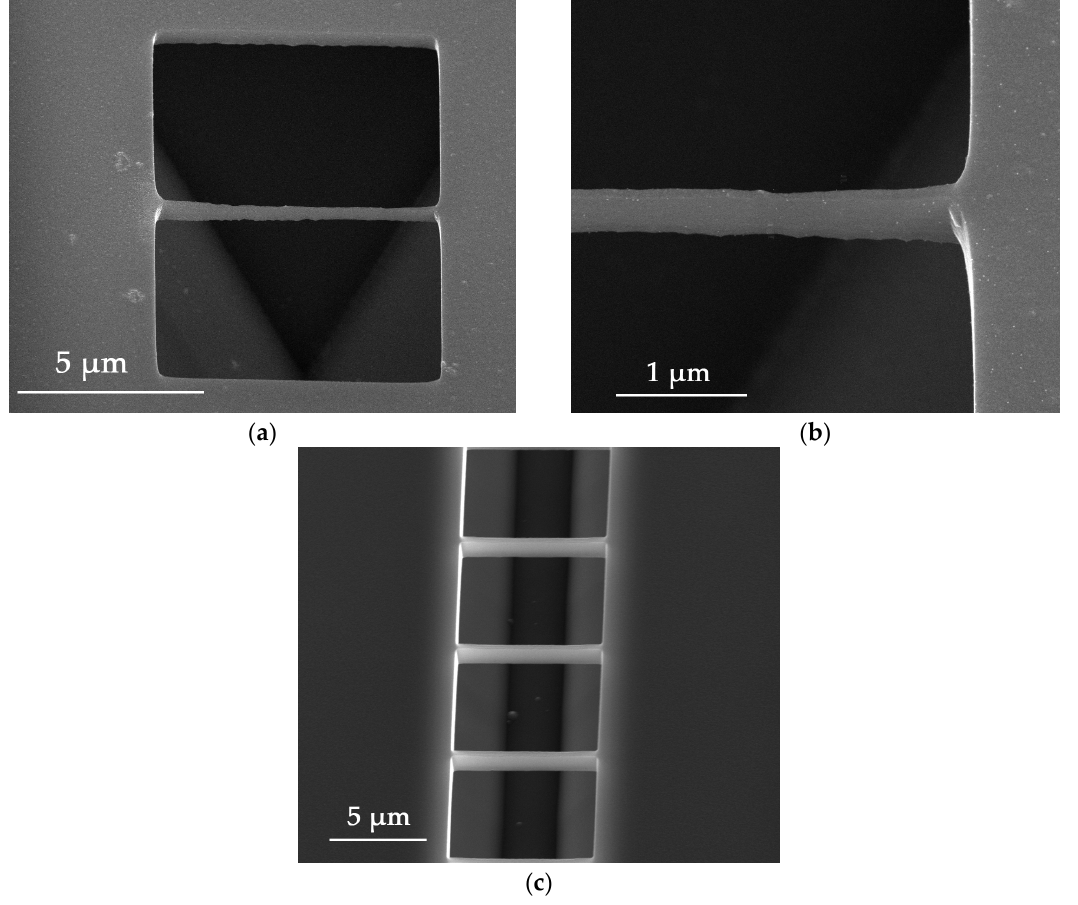
Figure 5. ( a ) Released nanowire structure with a length about 7 μ m; ( b ) detail of the nanowire, the height is about 280 nm and width is about 55 nm; ( c ) simultaneously released nanowire